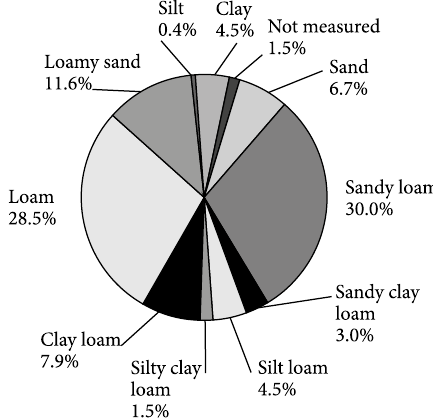
Fig. 7. Survey response of soil texture classes (n =